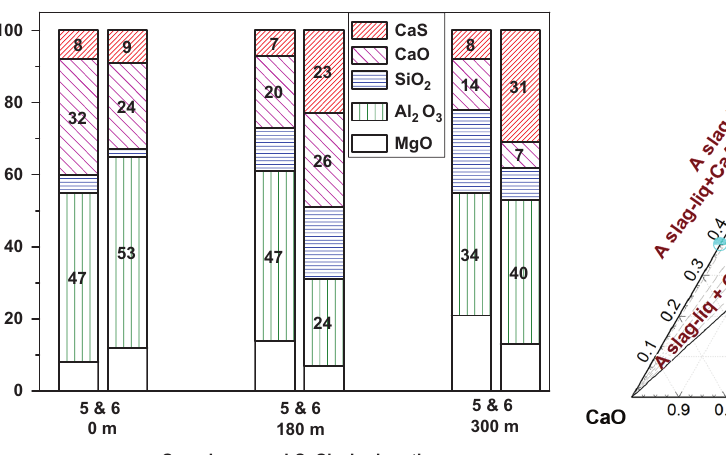
Figure 6: Effect of CaSi wire length on composition of inclusions.